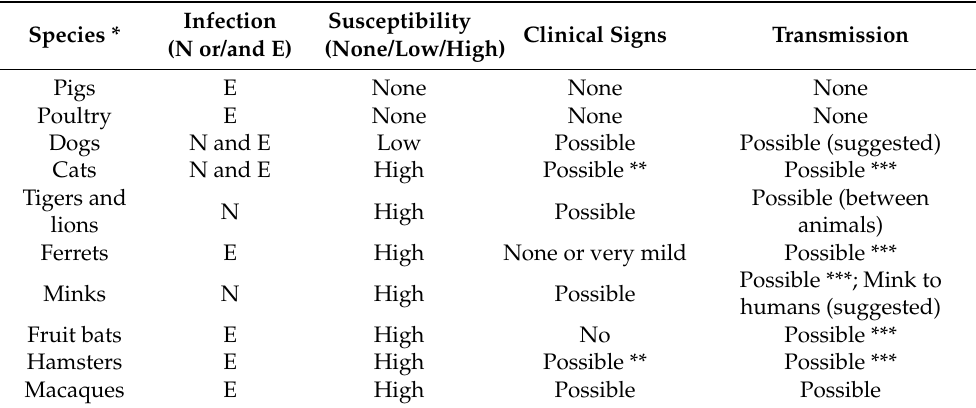
Table 1. Animal species that are proven to be susceptible to infection with SARS-CoV-2 (natural or/and experimental infection). Infection Susceptibility Clinical Signs Transmission Species * (N or/and E) (None/Low/High)